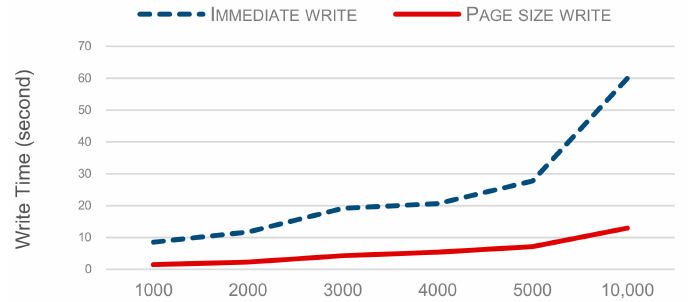
Figure 15. The time needed for write of a certain number of RDF